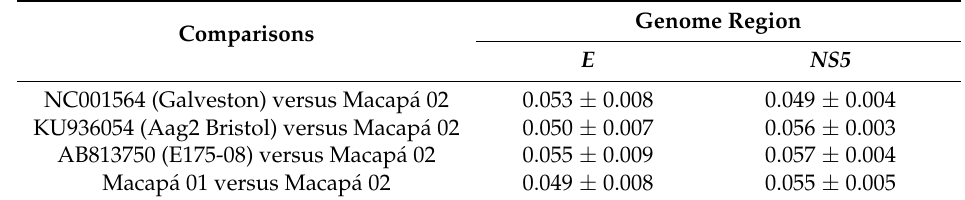
Table 2. Genetic distances between the strain Macap á 02 and other strains of CFAV according to two genome regions ( E and NS5